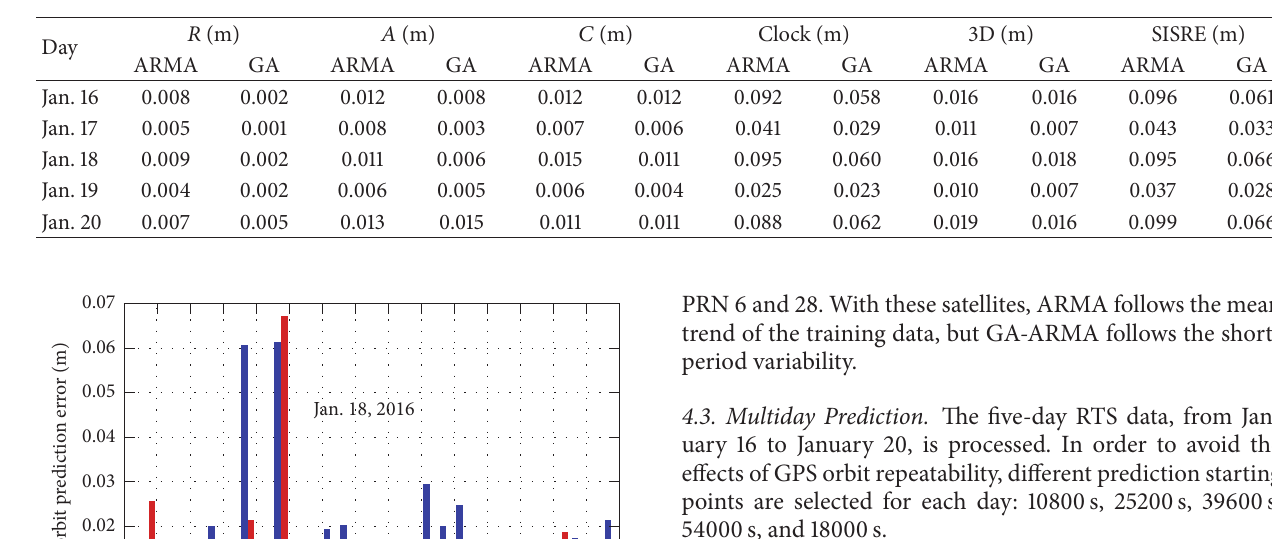
Table 2: Error statistics of orbit and clock predictions (January 16–20, 2016).